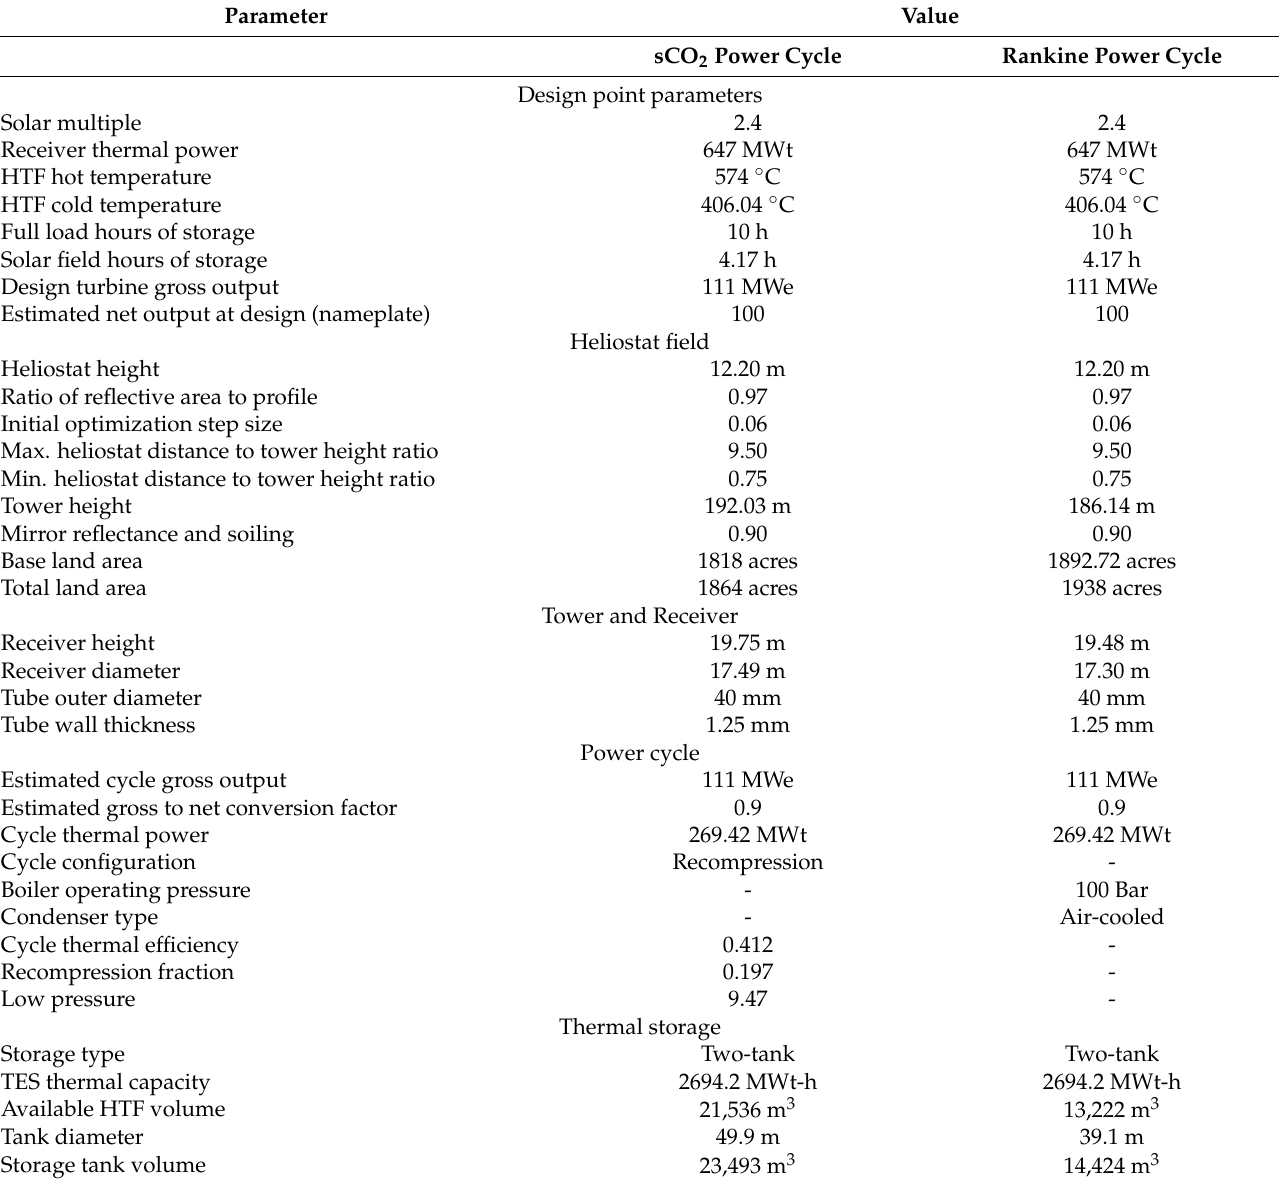
Figure 3. Optimized field ( a ) sCO 2 power cycle and ( b ) Rankine power cycle. Table 1. Technical parameters used for the simulation [11,45]. Table 1. Technical parameters used for the simulation